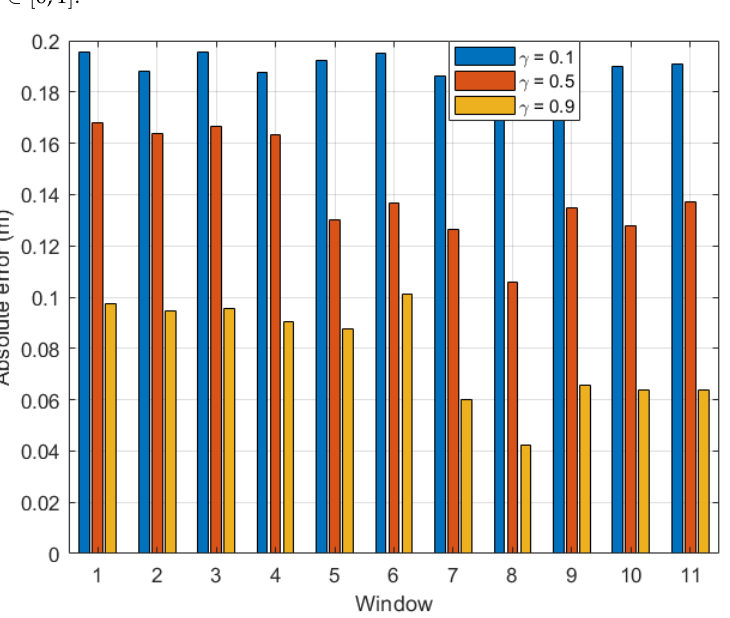
Figure 8. Indoor walking (dataset 2): absolute error with respect to time windows tw i , i ∈ [ 1,11 ] . As a result, the optimal γ for calculating the upper threshold for an indoor walking activity in Equation (13) was found to be 0.9, which is relatively close to the sub-optimal value γ = 1 chosen in [34]. The above estimation error could be as small as 3.02% of the real step